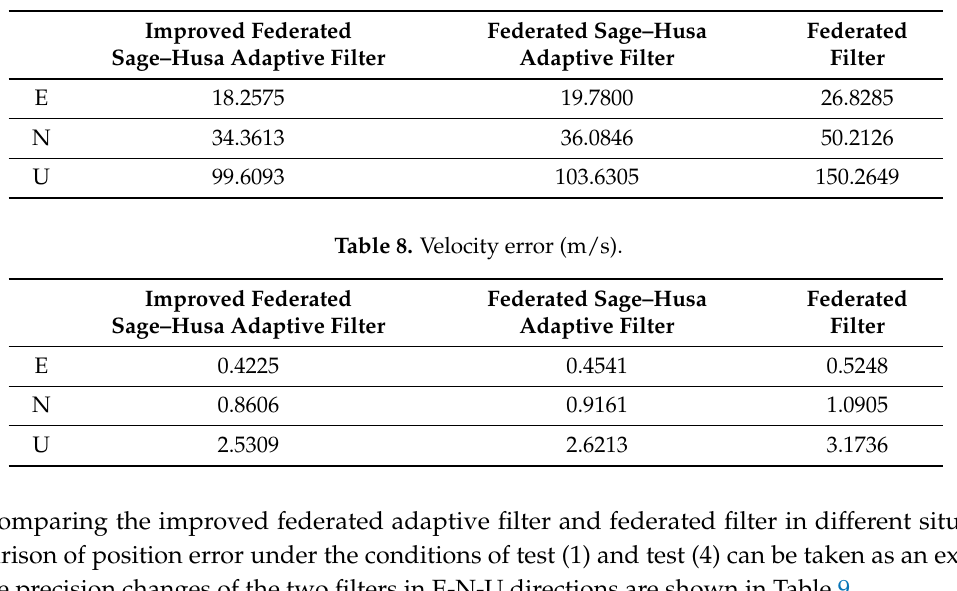
Table 7. Position error (m).